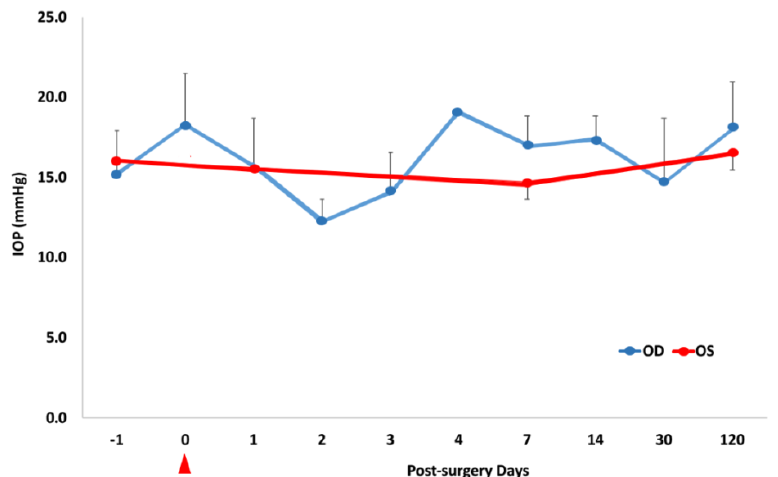
Figure 8. IOP changes graphed over time following the two-port partial pars plana vitrectomy. Red data points = control eyes; blue data points = surgical eyes. The red marker at 0 on the x-axis indicates the time immediately following the vitrectomy.